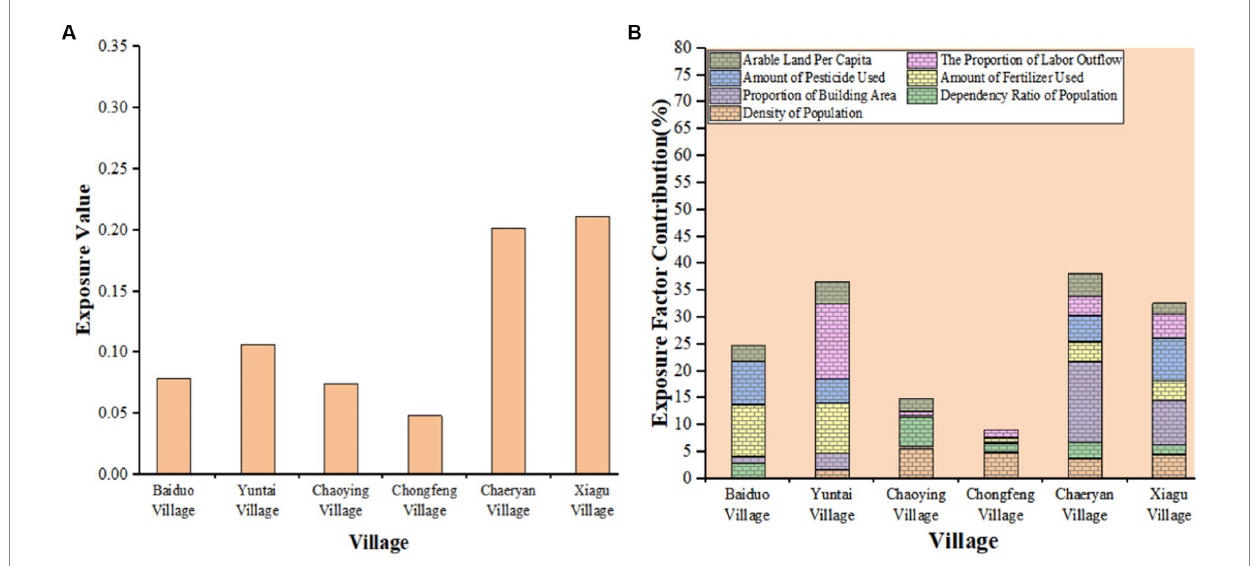
FIGURE 4 Exposure analysis of villages ecosystem in the KDC. (A) Exposure values. (B) Exposure factors